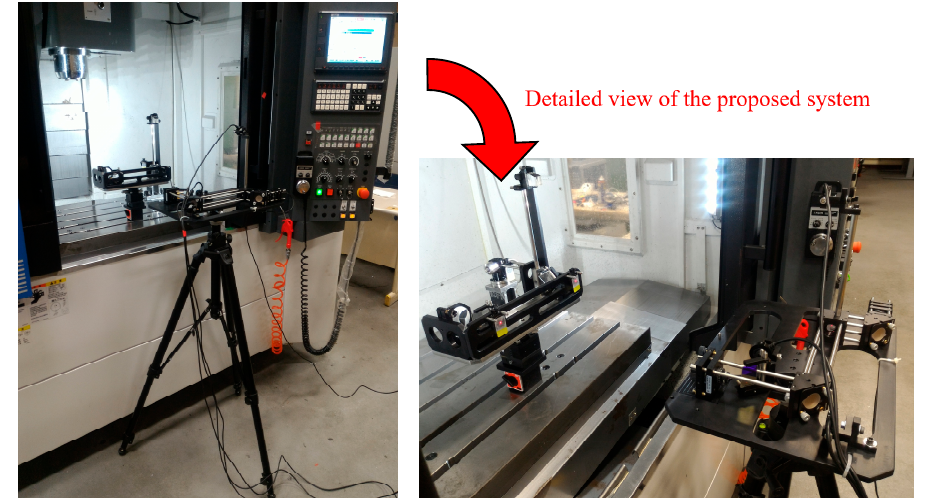
Figure 11. Measured machine tool and proposed prototype.